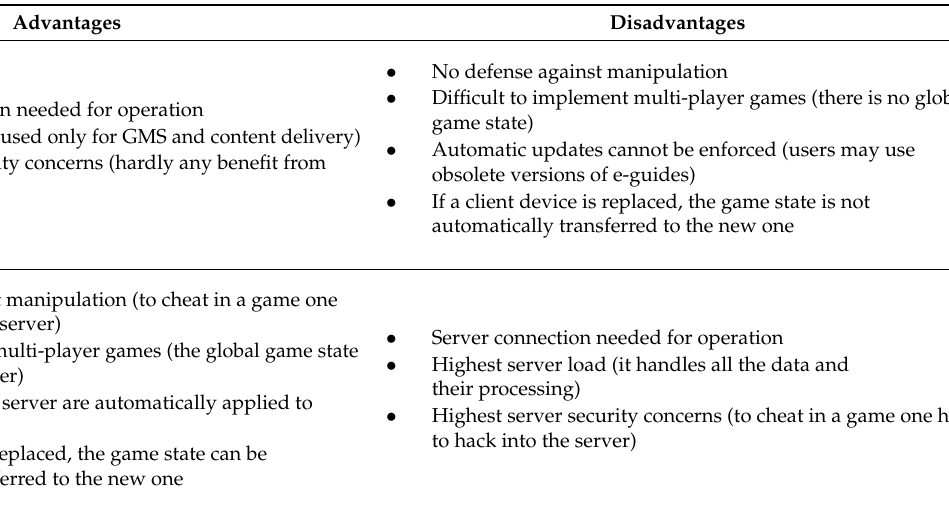
Table 3. Advantages and disadvantages of the primary e-guide gamification system